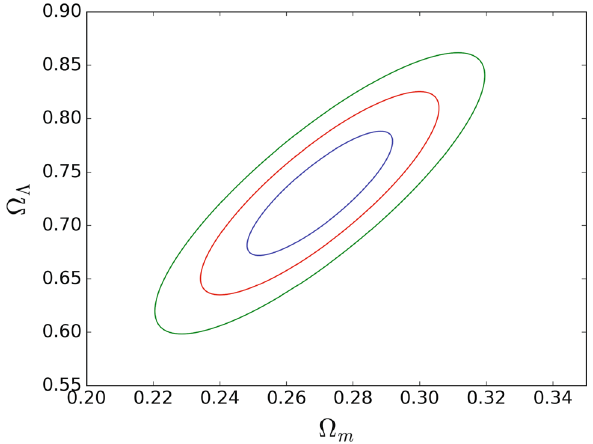
Fig. 10 Constraint on Ω m and Ω Λ for 3-year-observation. The blue, red, green curve denote 1 σ, 2 σ, 3 σ confidence region respectively. And the FoM of simulation data is